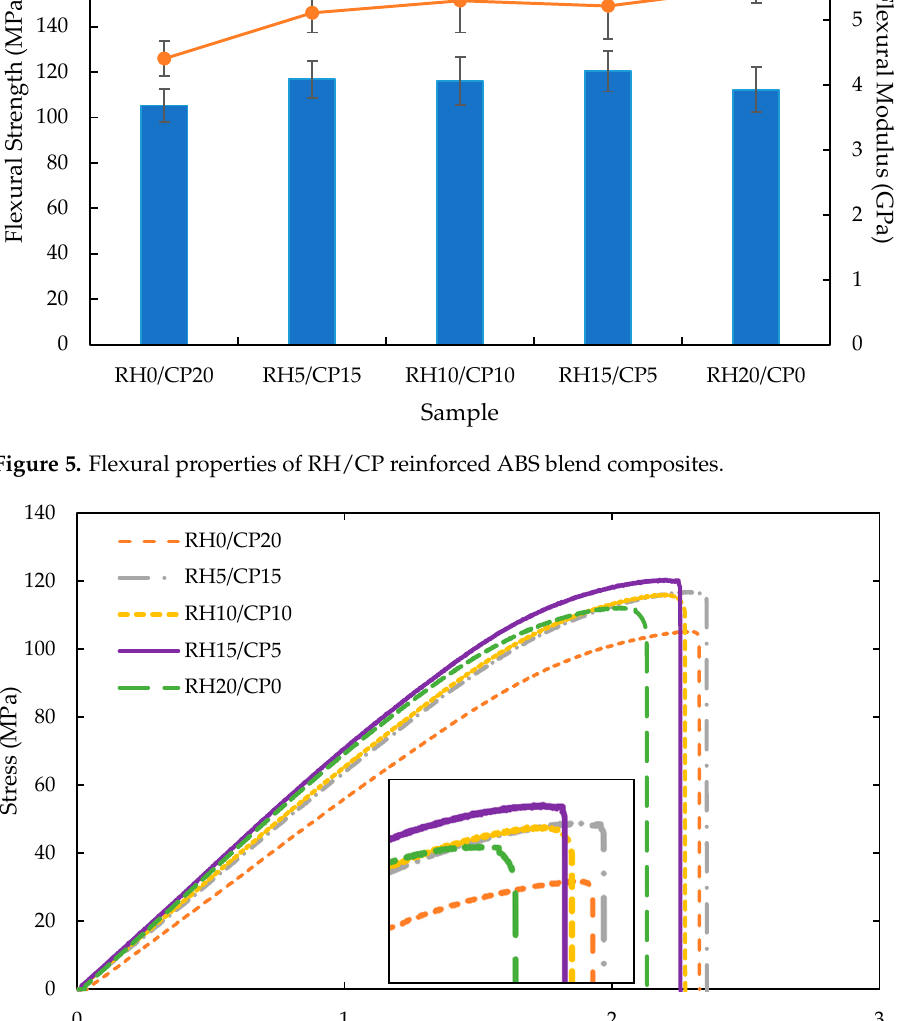
Figure 7. Impact behaviour of RH/CP reinforced ABS blend composites. 3.6. Fracture Surface Micrograph Figure 8 demonstrates the differences of fracture surface by using SEM for the com- posite containing RH15/CP15 and RH0/CP20 filler content. Filler fracture and matrix de- lamination are predominated in the RH15/CP15 specimen’s morphological surface, as il- lustrated in Figure 8a. Matrix cracking and the presence of void on the interface was also observed. It can be suggested that the stress was well scattered between the filler and thermoplastic matrix due to the clean braking surface. It was also indicated that this com- posite failed in the brittle mode failure. This means that an excellent interface bonding between filler and matrix was formed, resulting in high tensile strength property. Matrix cracking and fiber breakage were observed as in Figure 8b. As shown from this figure, more cavities were formed in this blend composite resulted from fiber pullout and air